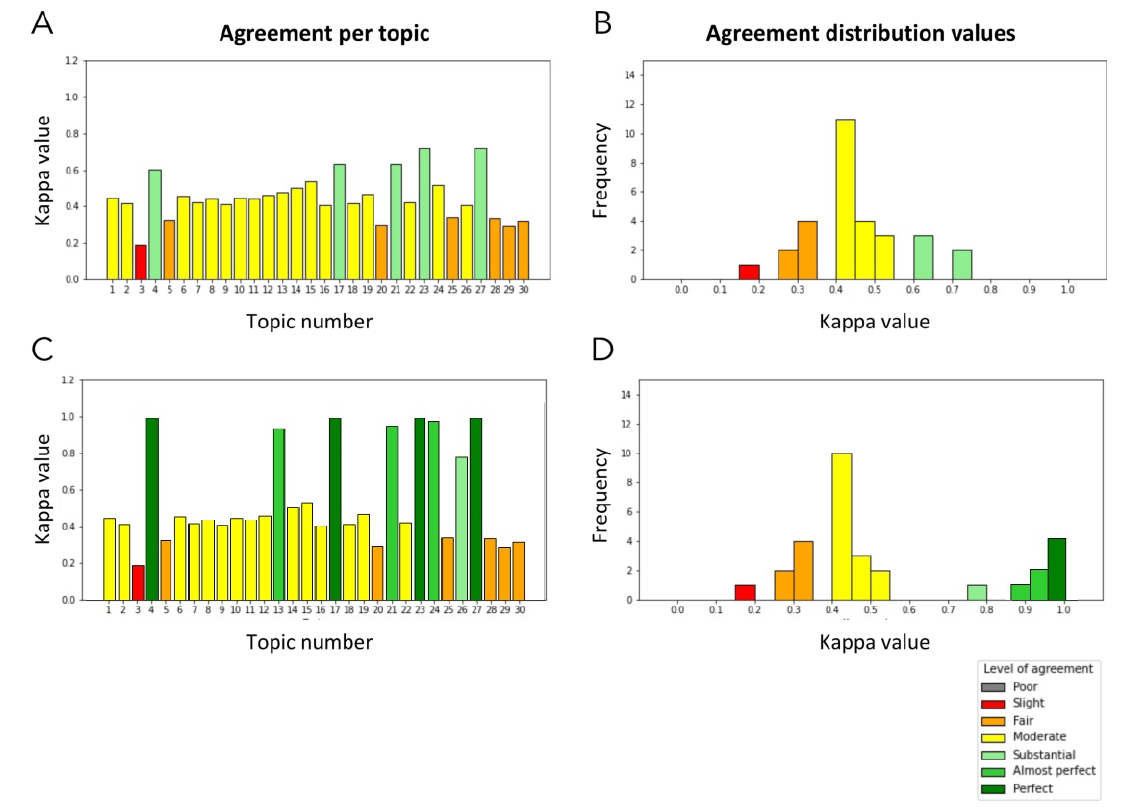
Figure 5. Consensus evaluation results comparing the topic labelling results from Model 2 against experts in the DOHaD field. Analysis of Cohen’s Kappa agreement statistics per topic ( A ) and by distribution ( B ) reveal that consensus among experts was substantial (n = 5), moderate (n = 18), fair (n = 6), and slight (n = 1) for the 30 topics. In eight topics (4, 13, 17, 21, 23, 24, 26 and 27), bimodal labelling was also considered ( C ), yielding better consensus measures ( D ). Table 2. Suggested labels for results for Model 1 of the text-mining model for 30 topics via pyLDAvis. Topic Number Suggested